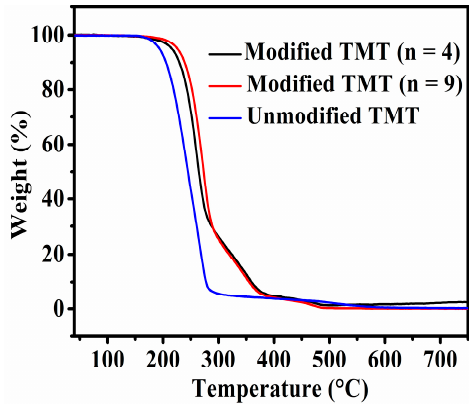
Figure 10. TG curves of modified TMT with different chain length comparing with unmodified TMT ( n : average embedded chain length of PCL).